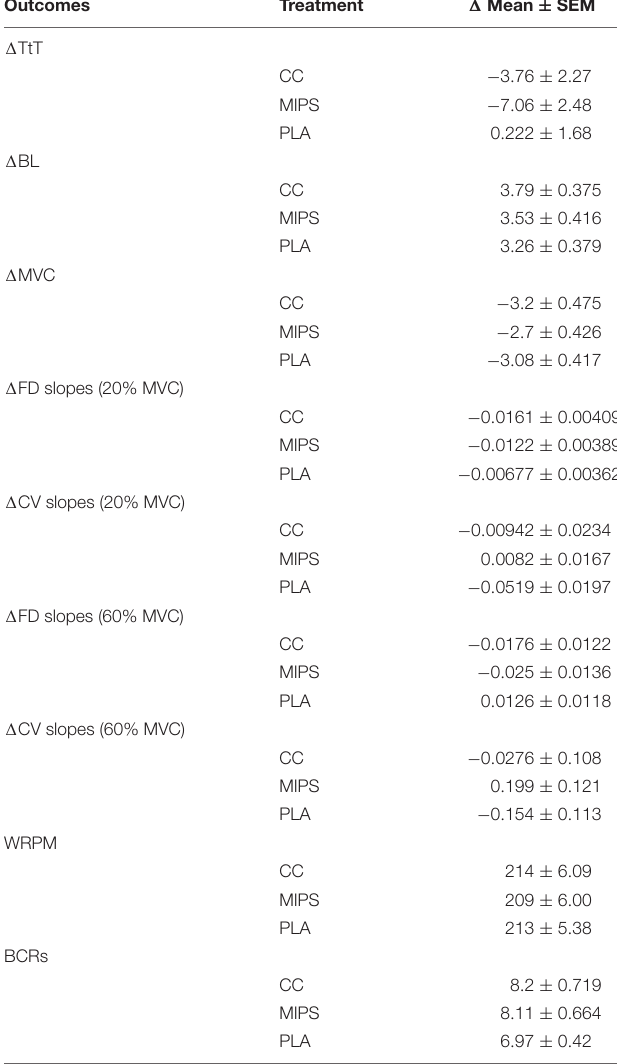
TABLE 2 | Pre-post mean differences and standard error mean (SEM) among different treatments on the investigated outcomes. Values are expressed as (cid:49) mean ±